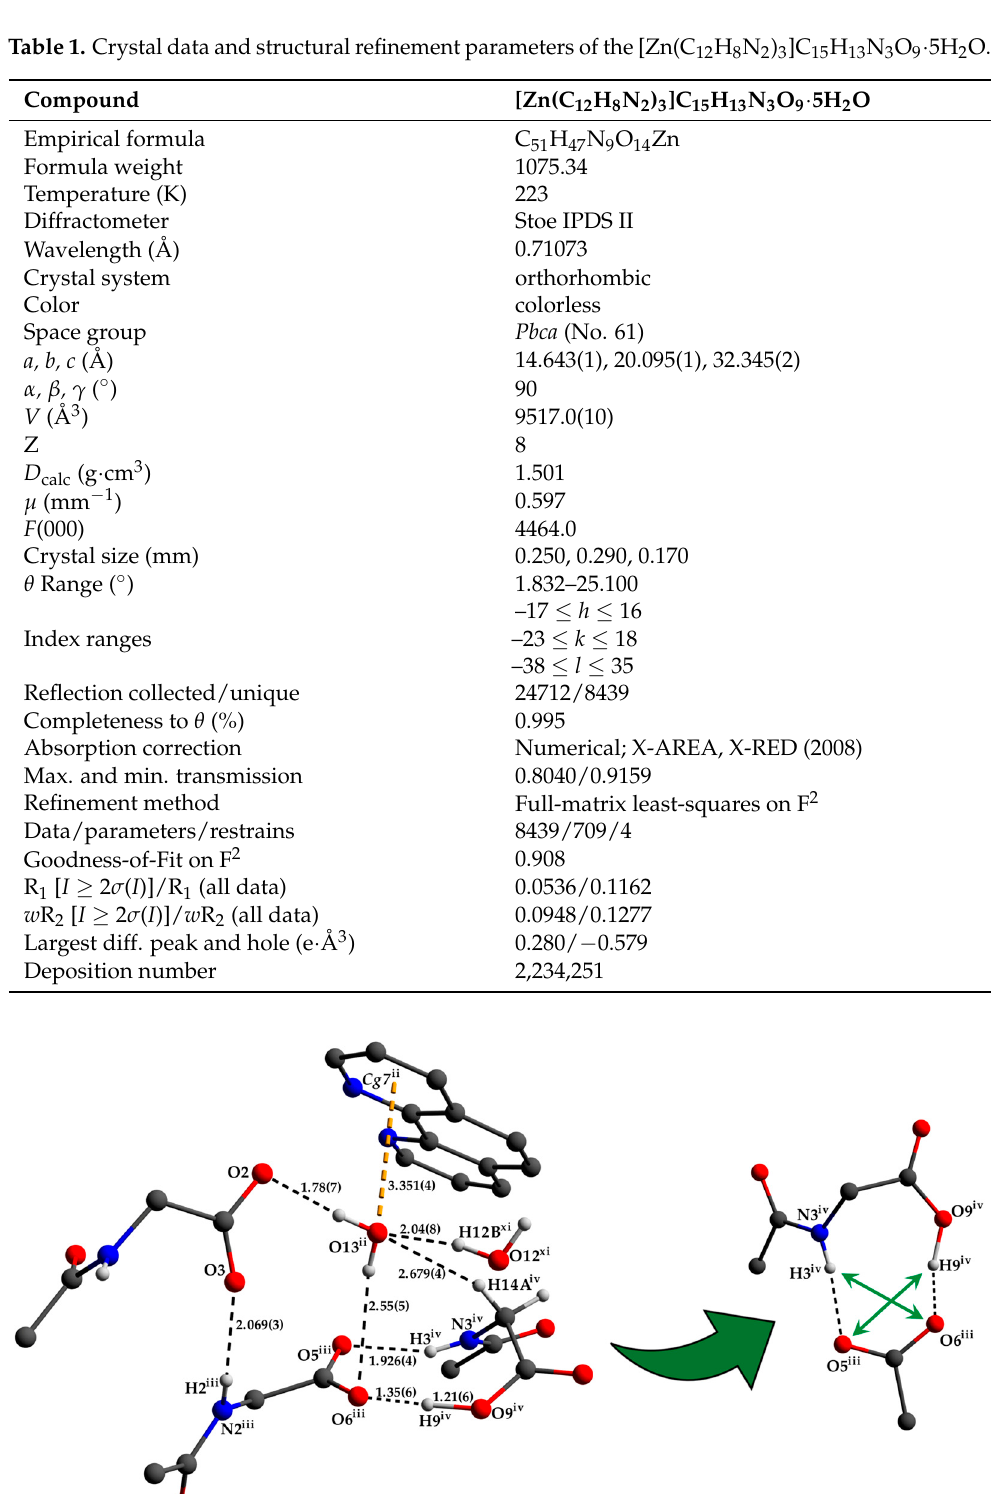
Figure 4. The perspective supramolecular network of the monolayers of the anions and cations connected via hydogen bonding and π – π -interactions. Atoms drawn with transparent van der waals radii. Atom color codes: bronze (Zn), red (O), blue (N), dark grey (C), and white (H).